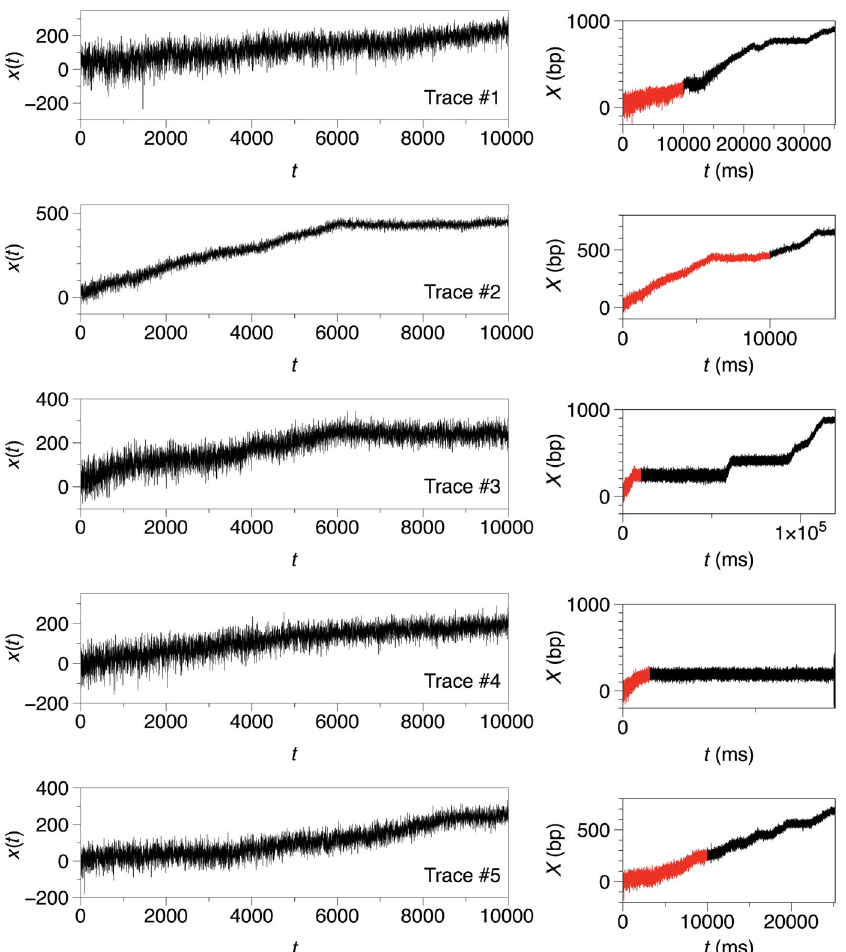
FIG. 23. Experimental traces of RNA polymerase I. In particular, and to make the inference problem more challenging, we only select the first 10 4 steps (about 10 seconds) for each trace. These parts are highlighted in red in the right panels, and plotted in the left panels. Interestingly, only for traces #2 and #3 are the two operating mechanisms — elongation and backtracking — observable and clearly discernible, while the rest are hidden below the